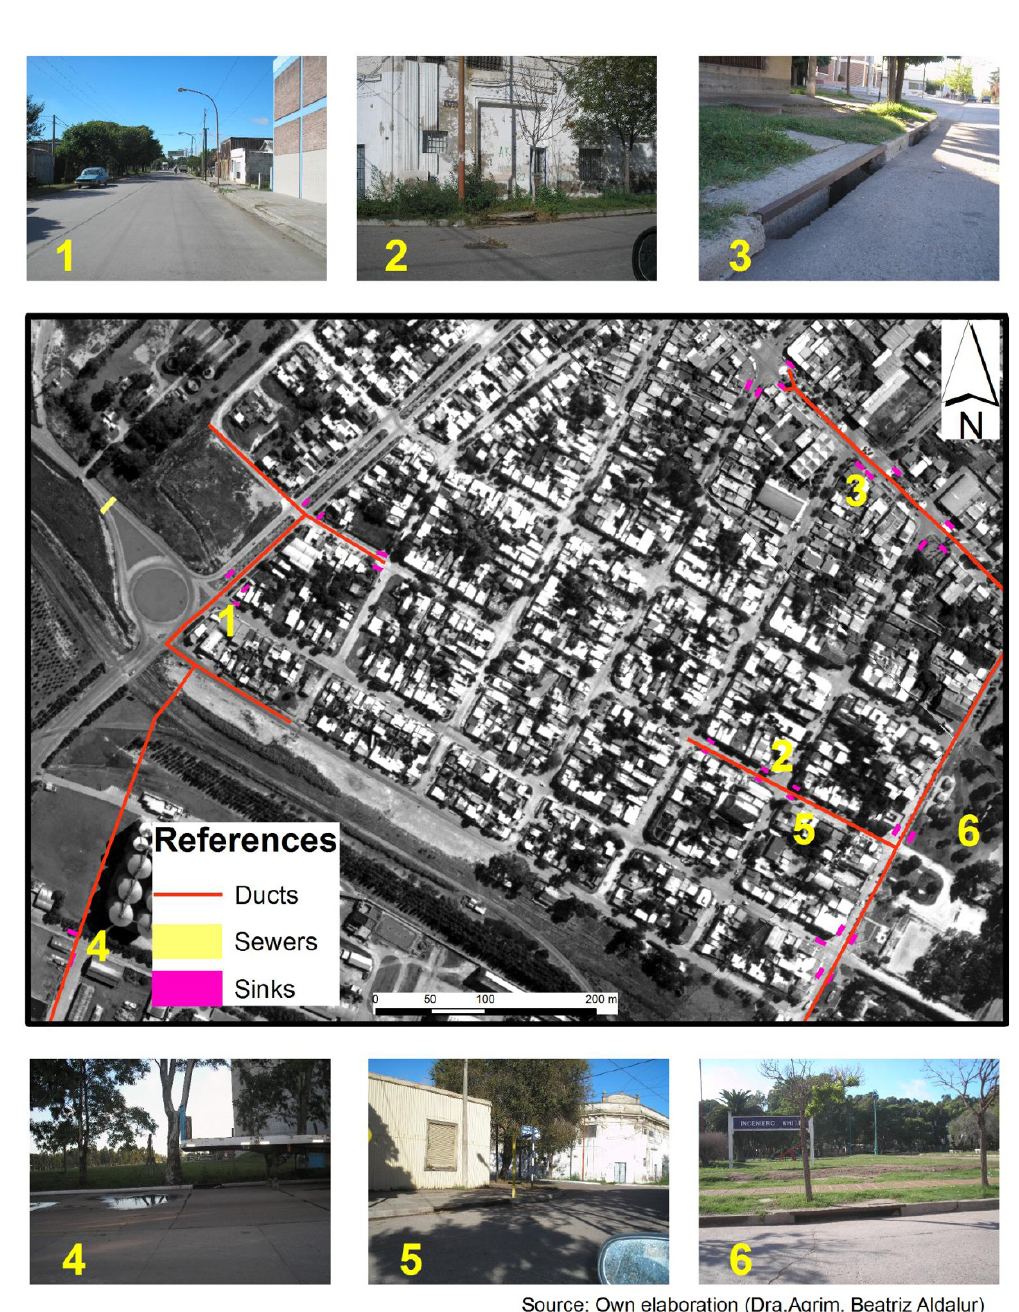
Figure 4. Detail of the enlargement area included in Figure